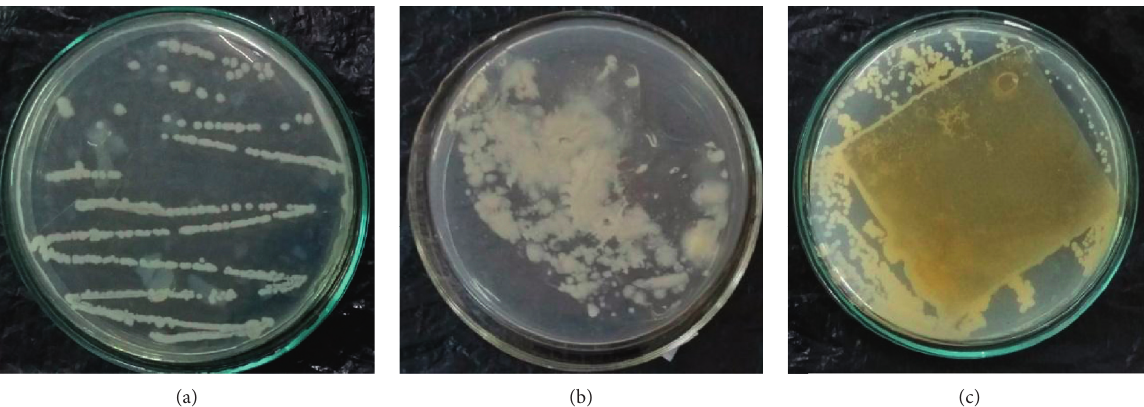
Figure 9: In vitro antifungal test of the composite film containing 245ppm CuNPs against C. gloeosporioides after 2 days. (a) Blank (without